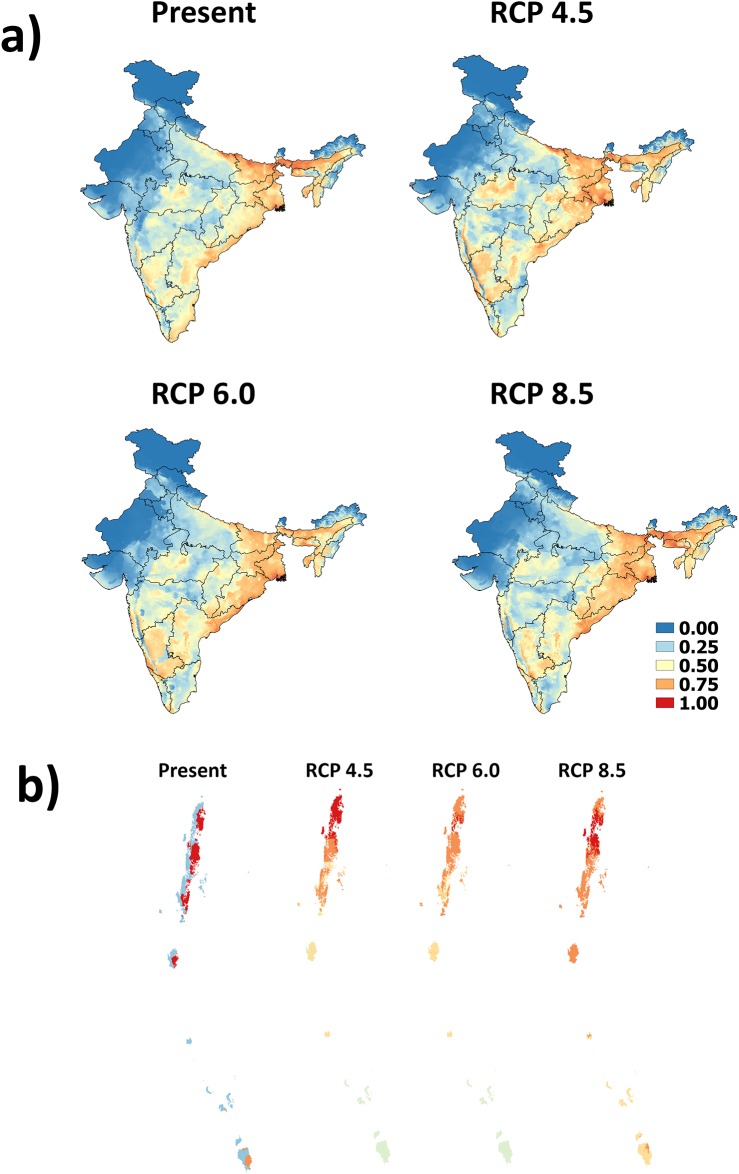
Potential distribution of A.fulica under current, and three climate change scenario (RCP 4.5, 6.0 and 8.0) a) for mainland India and b) Andaman and Nicobar Islands.Legend: Blue to red colour indicates unsuitable to highly suitable areas